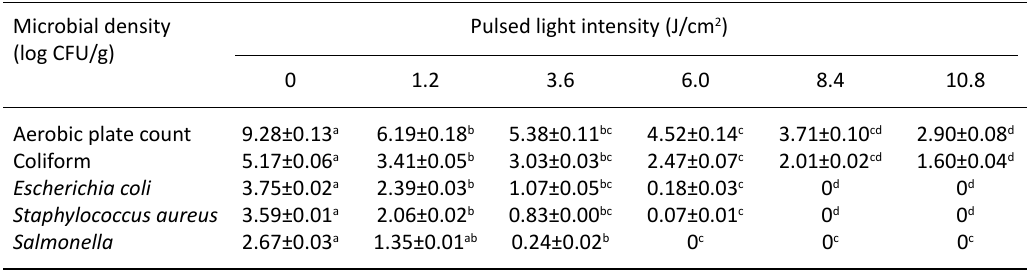
table 1. Microbial density (log CFU/g) on Chinese kale affected by pulsed light intensity (J/cm 2 ) Microbial density Pulsed light intensity (J/cm 2 ) (log CFU/g)